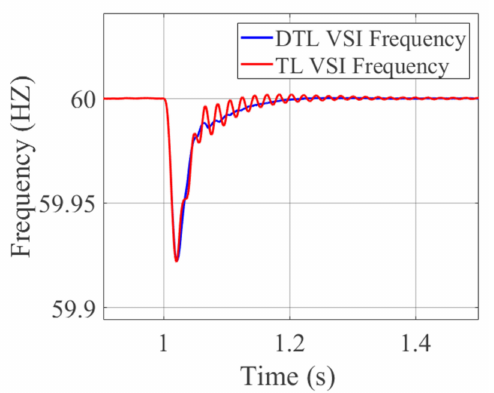
Figure 11. System frequency of the grid-connected TL VSI and grid-connected DTL